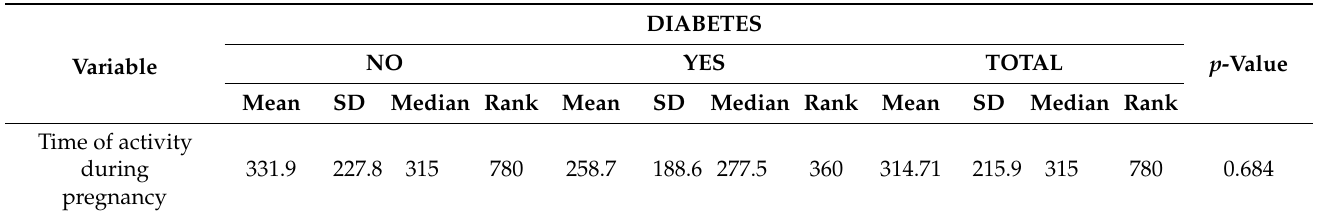
Table A6. Time of activity during pregnancy in each study group (expressed in minutes).